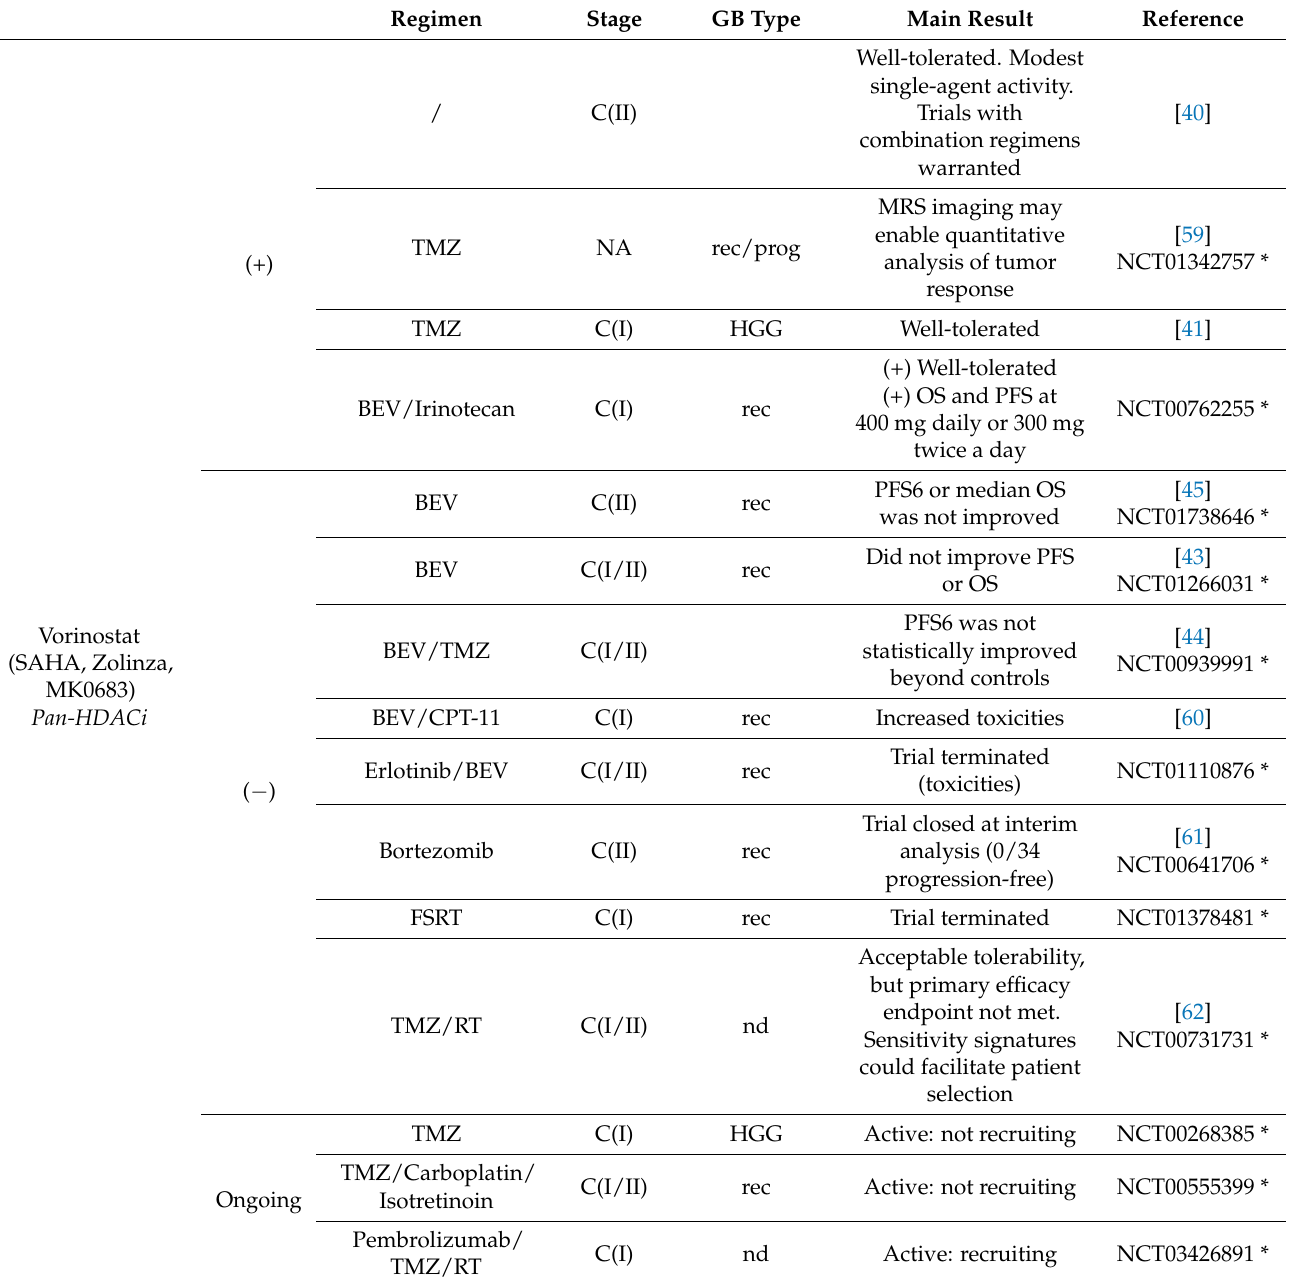
Table 1. Overview of clinical trials on HDAC inhibitors (HDACi) in high-grade